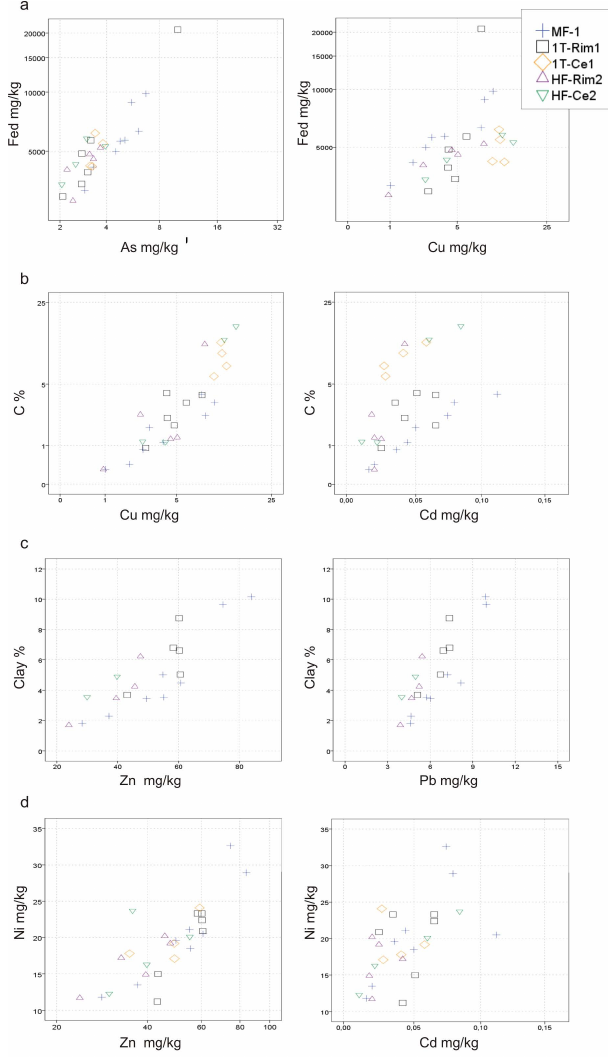
Fig. 6. Scatterplots showing the interrelation between the selected elements and the general soil properties in the soil profiles of Samoylov Island. ( (a) – correlation between the elements and a well crystallized form of iron oxide, (b) – the elements and organic car- bon content, (c) – the elements and clay content, and (d) – correla- tion between the